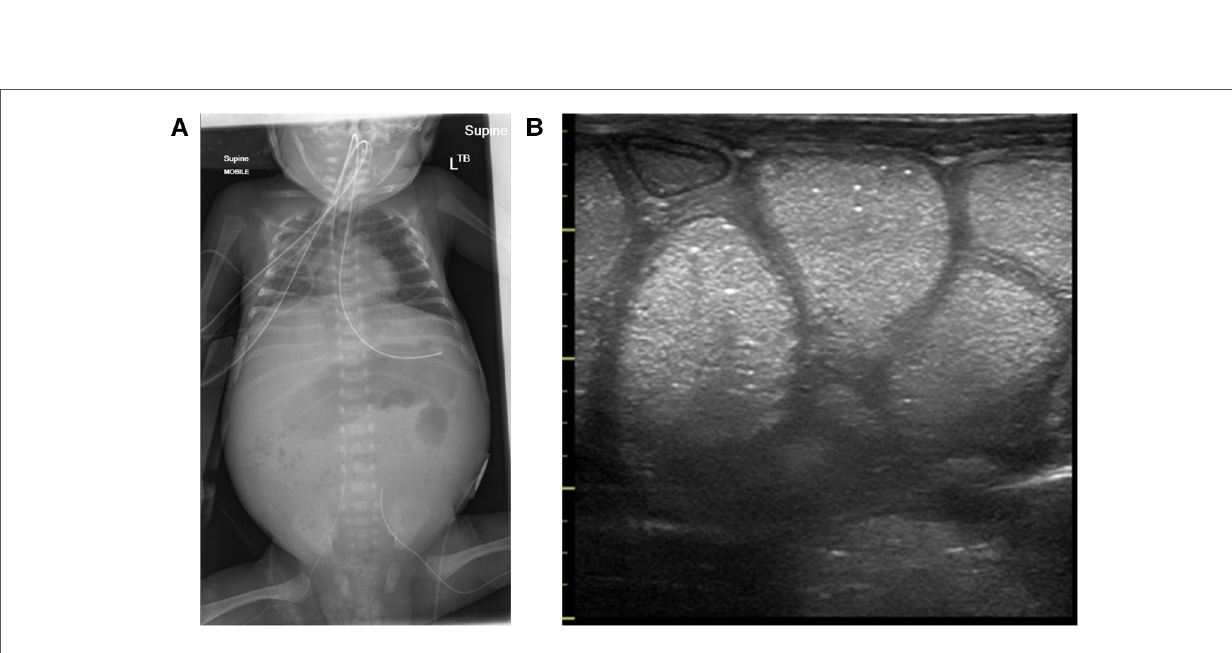
FIGURE 14 Milk-curd obstruction concurrent x-ray and point-of-care abdominal ultrasound fi ndings. ( A ) Plain abdominal x-ray showing paucity of bowel gas with a soap-bubbly appearance on the right. ( B ) The sonographic appearance of the bowel showing islets of echogenic homogenous material within the lumen maintaining the normal bowel-wall sonographic